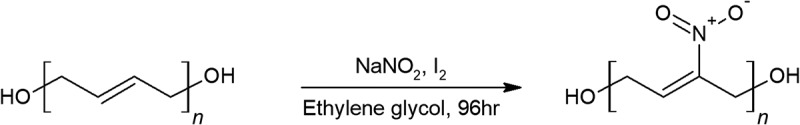
one-pot synthesis of nitro-HTPB.